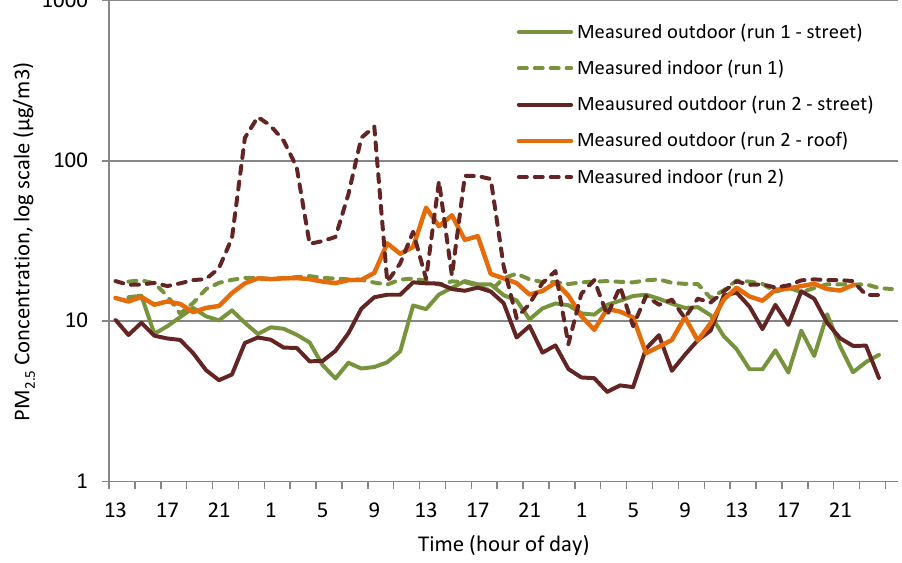
Figure 9. Measured indoor and outdoor PM 2.5 concentrations at M c 3 (run 1 and run 2). Int. J. Environ. Res. Public Health 2015 , 12